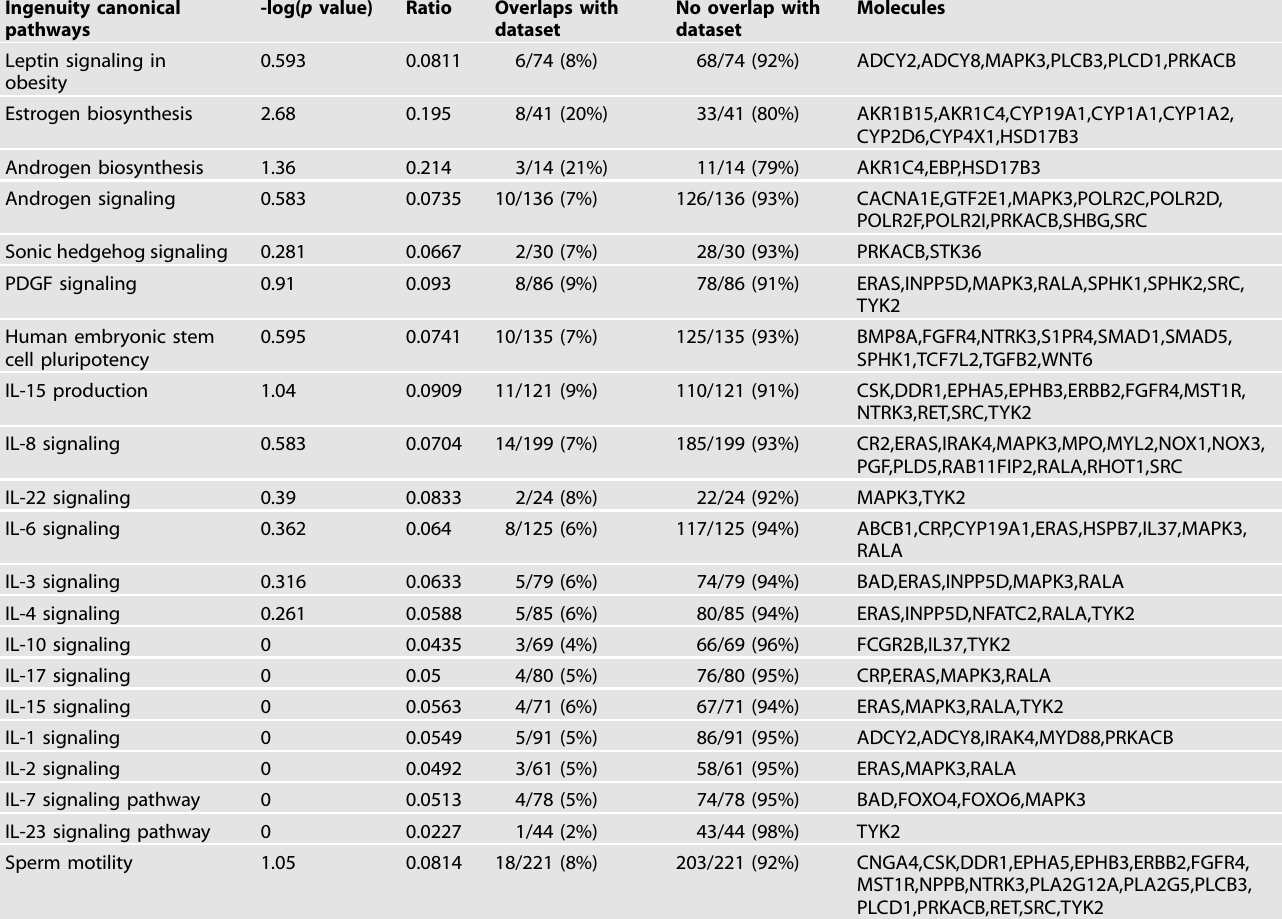
Table 2. Canonical pathways with which leptin-induced/suppressed candidates were involved. Ingenuity canonical